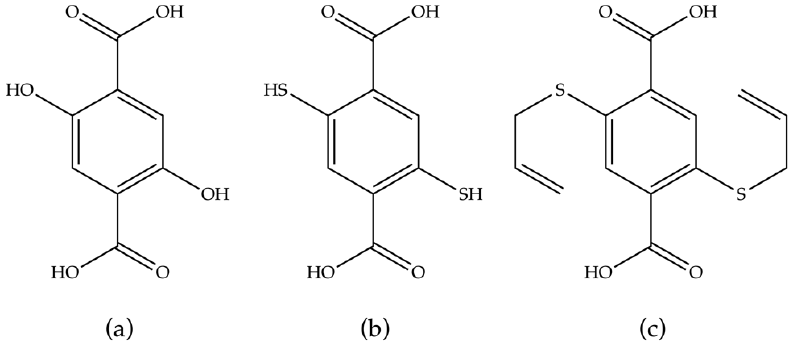
Figure 1. Linkers with high densities of donors: ( a ) 2,5-dihydroxybenzene dicarboxylic acid, (DOBDC); ( b ) 2,5-dimercaptobenzene dicarboxylic acid, (DMBDC); ( c ) 2,5-bis(allylsulfanyl)benzene dicarboxylic acid, (ASBDC).